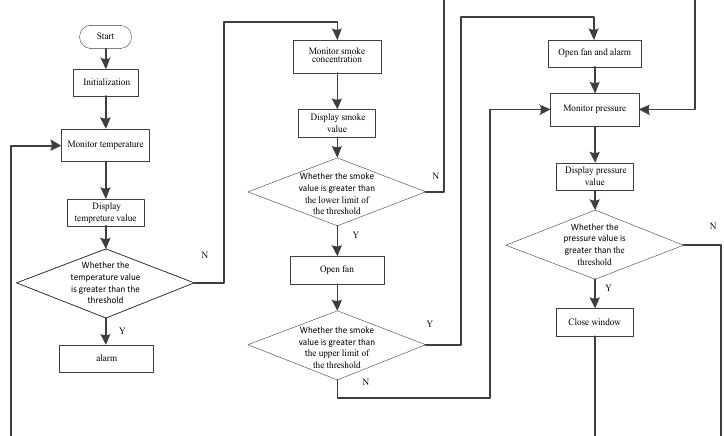
Fig. 5 . The software flowchart of this